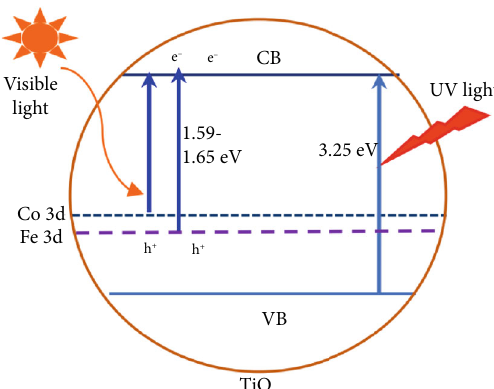
Scheme 1: Band structure of TiO and Fe 3+ . VB: valence band; CB: conduction